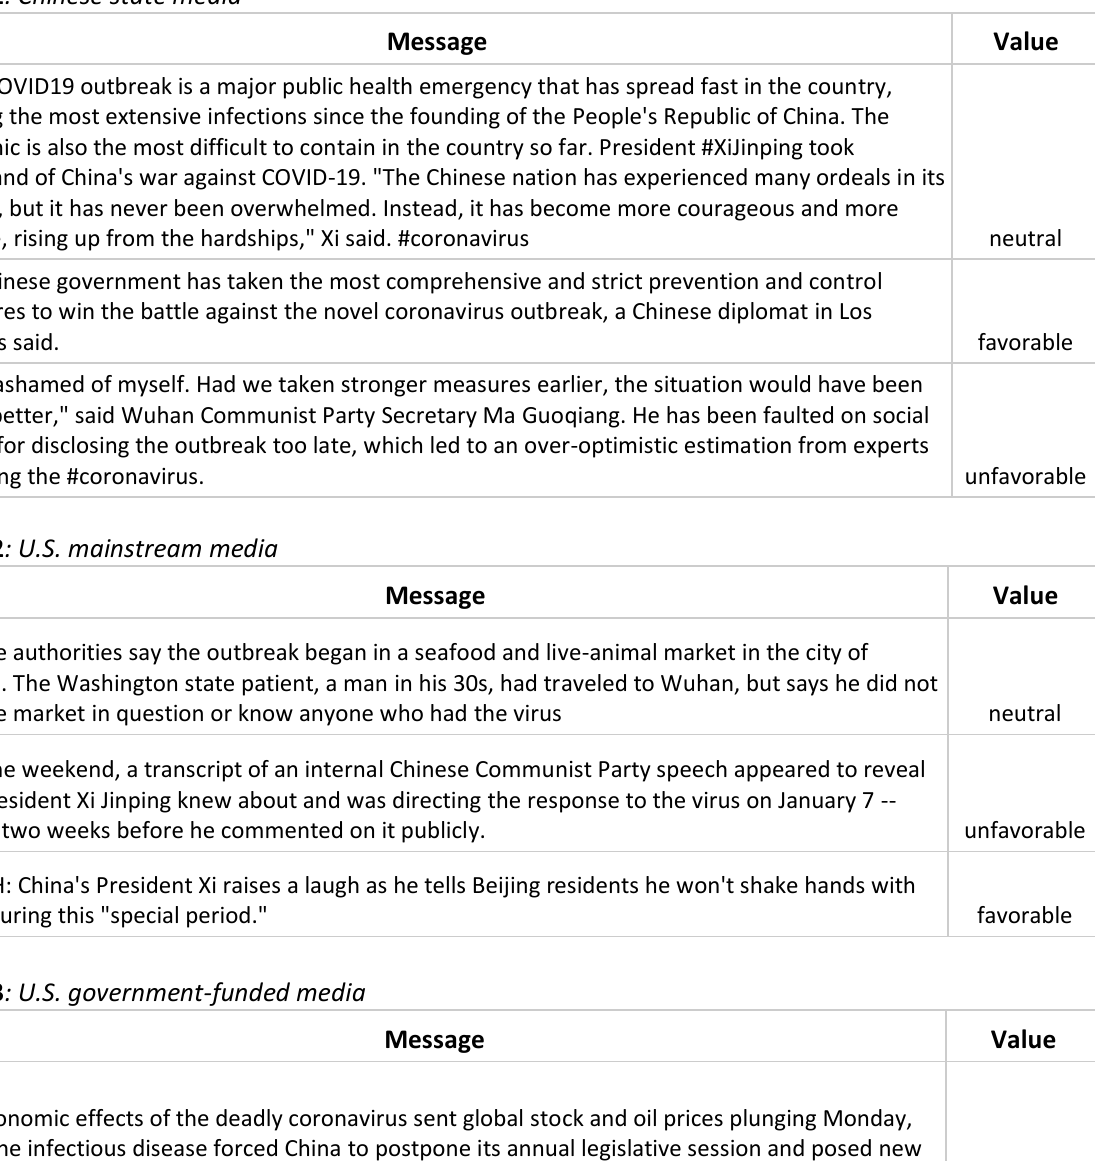
Table 1 : Chinese state media